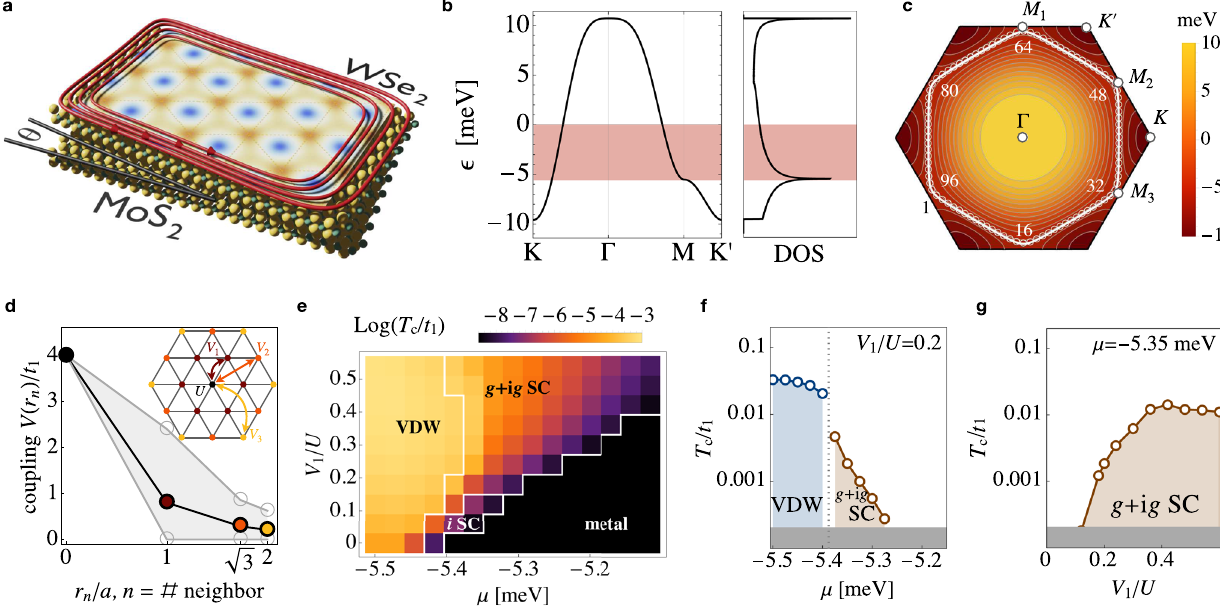
Fig. 1 Correlated phase diagram of hetero-bilayer TMDs. a Sketch of a twisted WSe 2 /MoS 2 bilayer with small twist angle θ . The resulting effective moiré potential 34,39 is indicated by the contour shading at the top. The four red lines represent the chiral edge modes of the topological superconducting state with N ¼ 4 . b Dispersion of the energy band ϵ k along high-symmetry lines and density of states (DOS). We explore fi lling levels indicated by the red band between half fi lling ( μ ~ 0) and Van Hove fi lling ( μ = − 5.5 meV, ~1/4 fi lling). c Nearly nested Fermi surface close to the Van Hove energy. Numbered open circles show the momentum resolution of the Fermi surface employed in the FRG approach. d Extended interaction parameters as function of distance r n / a , a is the moiré lattice spacing 34,39 . The gray area marks the explored range of interactions, which are tunable by the environment. Inset: sketch of the interactions on the triangular moiré lattice. e Phase diagram as function of nearest-neighbor repulsion V 1 and fi lling controlled by the chemical potential μ extracted from the Fermi-liquid instabilities in the FRG fl ow for U = 4 t 1 , V 2 / V 1 = 0.357 and V 3 / V 1 = 0.260 (see Fig. 1d). The background color encodes our estimate for the critical temperature (see methods). We fi nd an instability towards a valley density wave (VDW) near Van Hove fi lling μ ≈ − 5.5 meV. It is fl anked by an i -wave superconducting instability ( i SC) for small V 1 / U and by a g -wave superconducting instability for larger V 1 / U . In the ground state, the g -wave superconducting instability forms a chiral g + i g state ( g + i g SC) characterized by winding number N ¼ 4 . The regime colored in black, does not show any instability within our numerical accuracy. f Filling-dependent critical temperature near Van Hove fi lling. Below the gray band, we cannot resolve any instability within our numerical accuracy. g Dependence of the critical temperature on the extended interactions tuned via V 1 / U at fi xed V 2 / V 1 , V 3 / V 1 slightly away from Van Hove fi